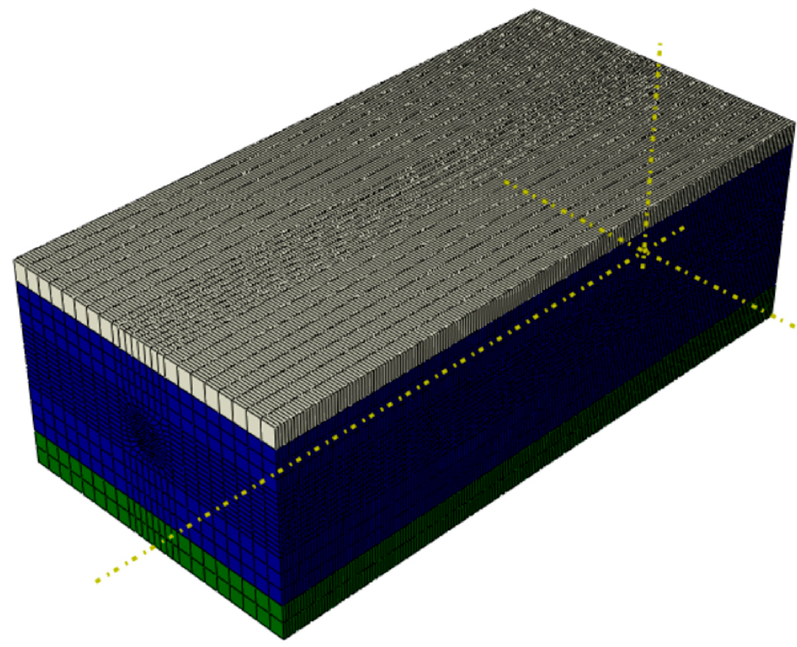
Figure 2. Schematic diagram of stratum grid division.